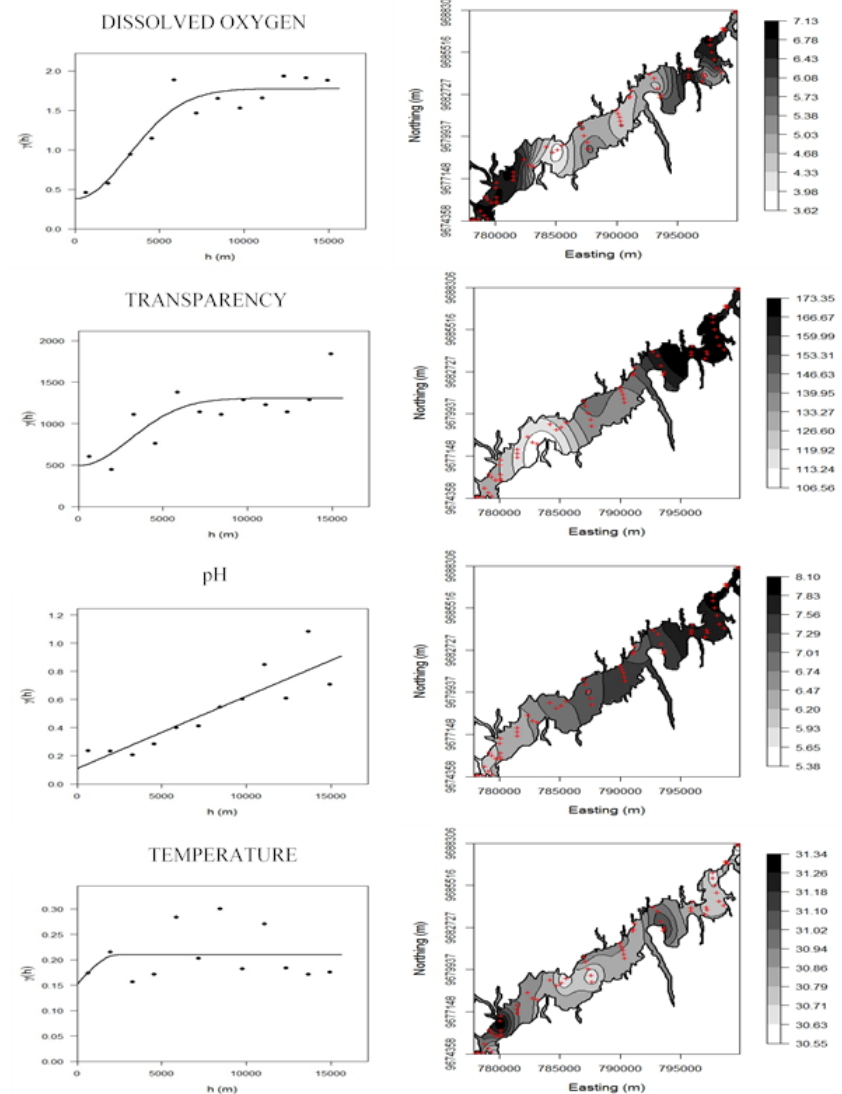
Figure 3. Semivariograms adjusted for the Gaussian model (Dissolved Oxygen and Transparency) and spherical (pH and Temperature) and their respective maps and scales of values obtained by the Kriging method for the Curuá-Una reservoir, in November 2016. Legends: Red cross (+) - each georeferenced point; Sequence of red crosses (+ + +) - transects; ( ) h γ - Semivariance; h (m) -